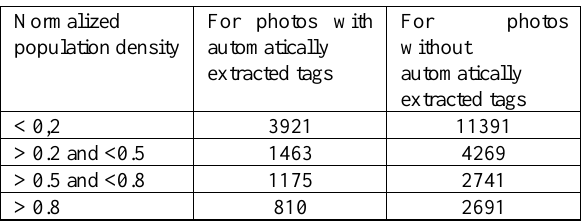
Table 3. Coordinate prediction results for photos with tag extraction using a neural